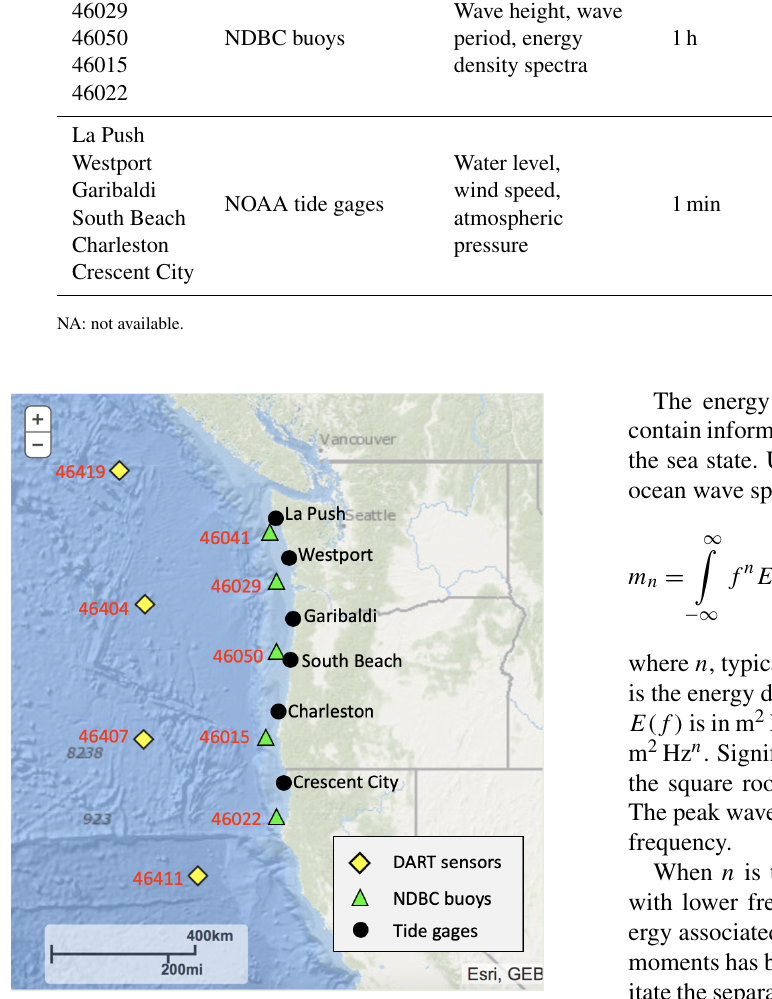
wave period – both recorded at 1 h intervals. Also used at these locations are wave spectral density, also recorded at 1 h intervals, across a frequency range of 0.02 to 0.485 Hz. Data acquisition starts at the 20th minute of each hour and contin- ues for 20 min. During this time, buoy motions are measured and then transformed from the temporal to the spectral do-